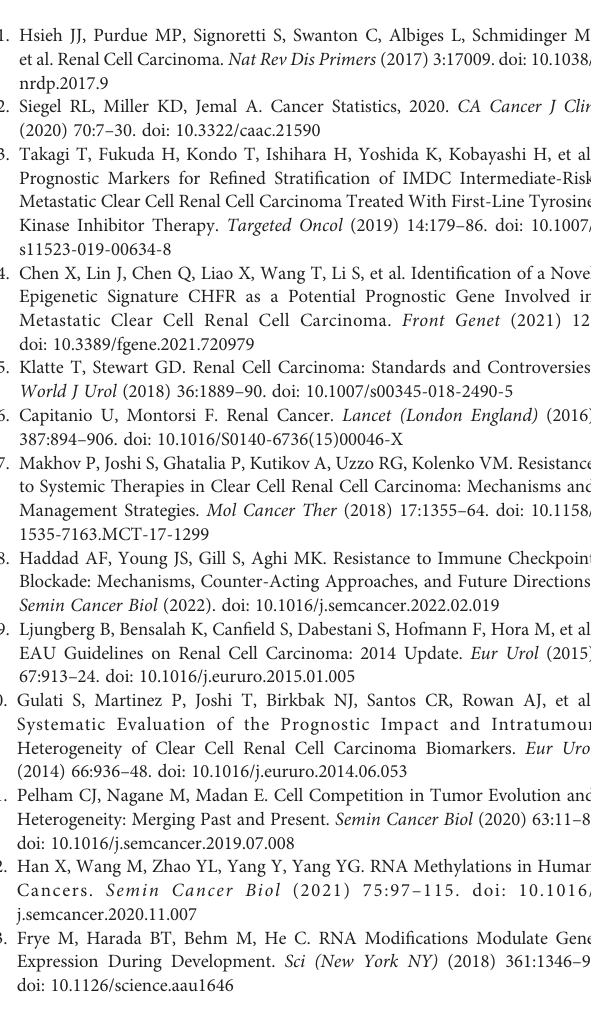
high- and low-risk subtypes in Japan cohort. (C) The time-dependent ROC curves analysis for m7Sig in Japan cohort. Supplementary Figure 9 | Single-cell analysis of ccRCC. (A) The t-SNE projections of major cell types in ccRCC. (B) The expression patterns of m 7 G regulators in different cell populations in TME of ccRCC. (C) The t-SNE plot of different cell populations according to tumor stage. (D) The expression patterns of m 7 G regulators in ccRCC with different tumor stages. Supplementary Figure 10 | The association between EIF4A1 mutation and immune cell in fi ltration in TCGA-ccRCC. Supplementary Table 1 | List of 7-Methygunaosime (m 7 G) related genes. Supplementary Table 2 | ClinicopathologicalfeaturesofdifferentsubtypesinccRCC. Supplementary Table 4 | List of discovered 138 kinds of small-molecule drugs that could be used as potential drugs for the treatment of ccRCC. Supplementary Table 5 | List of subtype-speci fi c upregulated